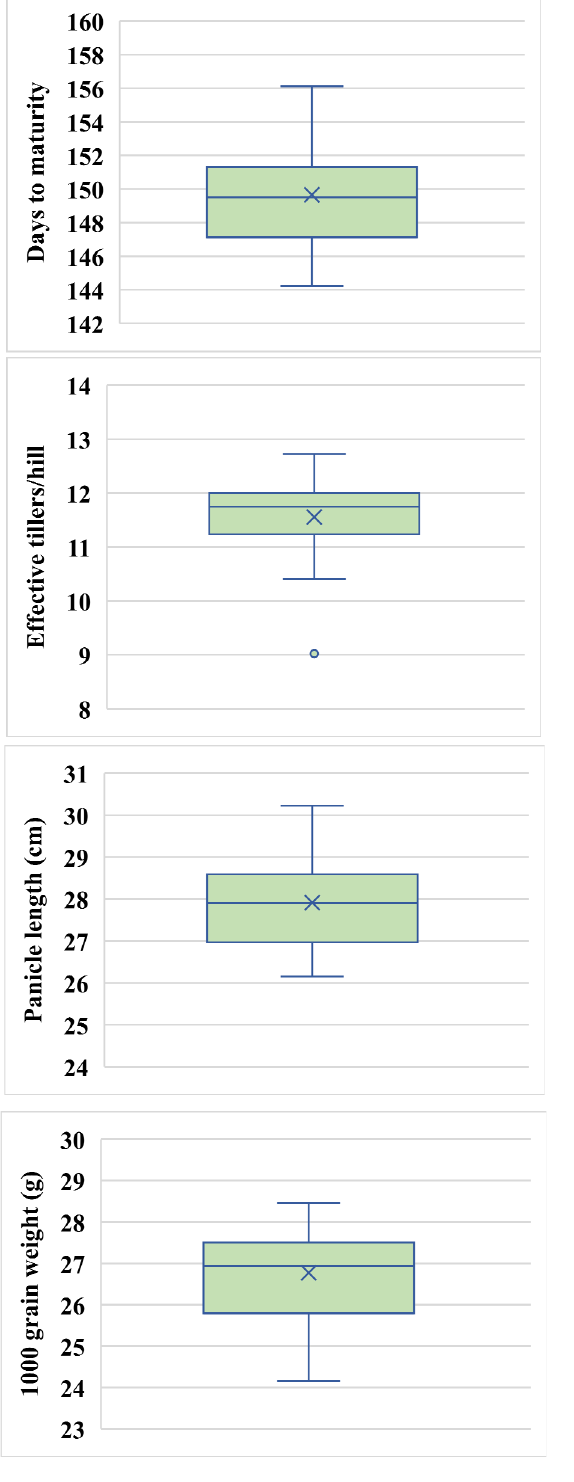
Figure 1. Boxplots showing descriptive statistics of 26 hybrid